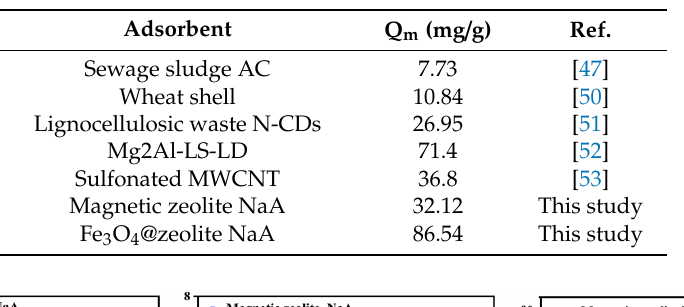
Table 3. Comparison of different adsorbents for Cu 2+ adsorption.